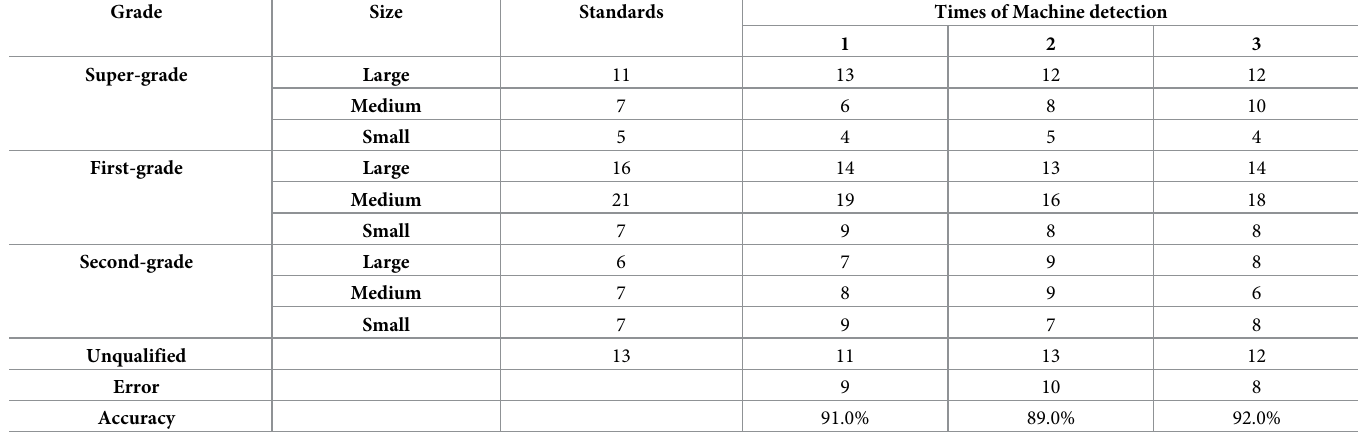
Table 5. The experimental